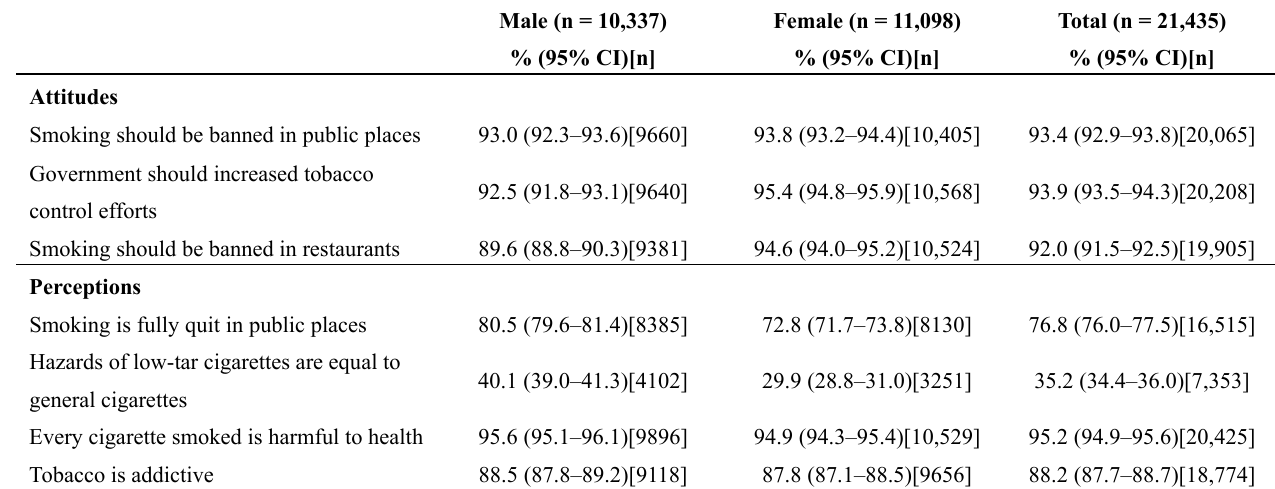
Table 3. Attitudes and perceptions towards tobacco control among adults from Jilin Province, China in